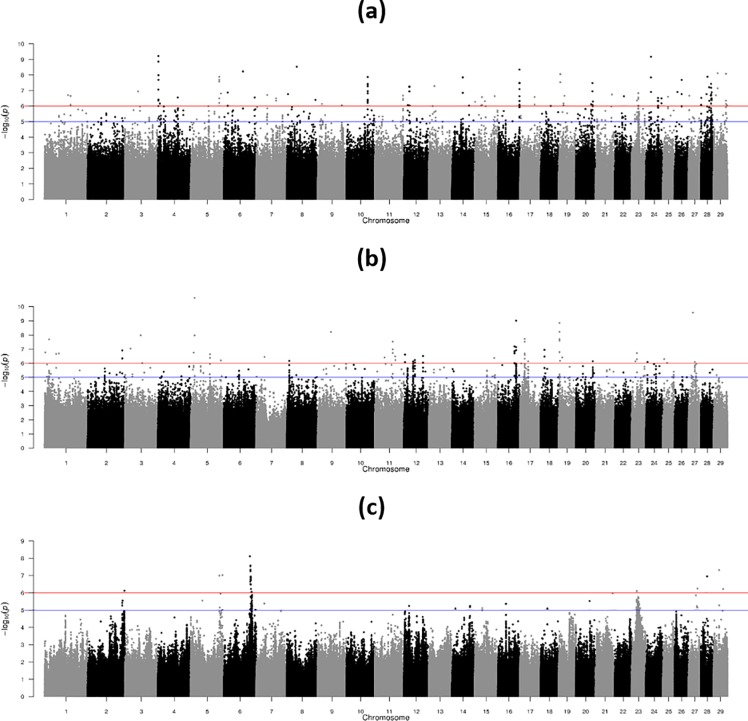
Manhattan plot showing–log10 (P-values) of association between each single nucleotide polymorphism effect and the weighted deregressed EBV for bovine tuberculosis infection in the within-breed analyses for (a) the 2,039 purebred Charolais bulls, (b) the 1,964 purebred Limousin bulls, and (c) the 1,502 purebred Holstein-Friesian bulls; red and blue lines represent genome-wide and suggestive thresholds, respectively.